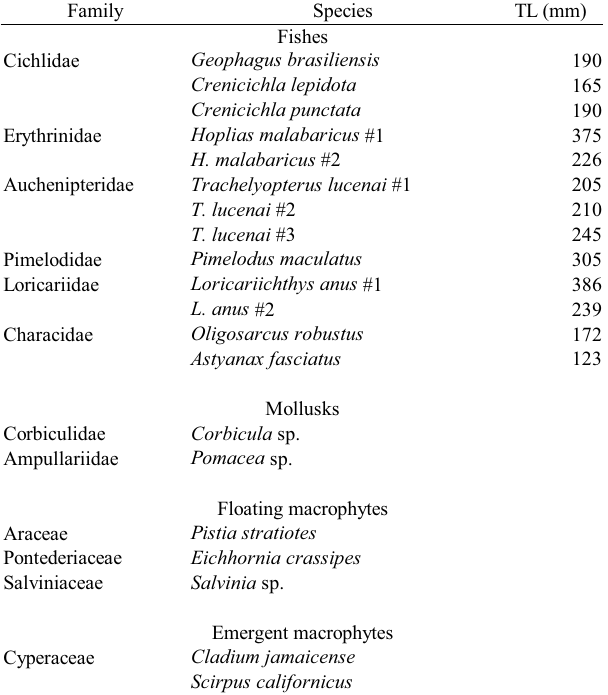
Table 1. Taxonomic status and total length (TL mm) of the individuals collected at Nicola Lake, Taim Hydrological Sys- tem. # symbols denotes different individuals of the same spe-